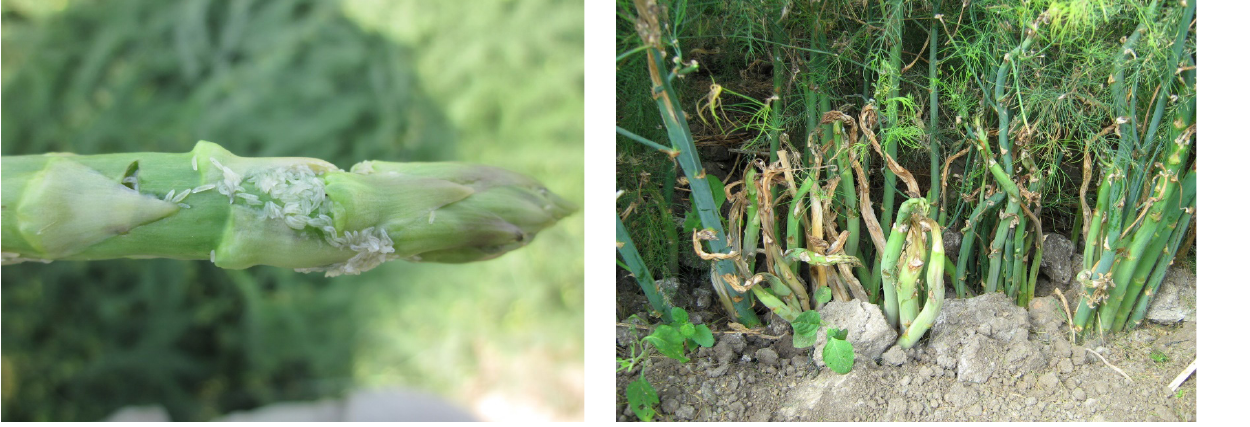
Figure 8. Asparagus spear infested by a large number of Prodiplosis larvae